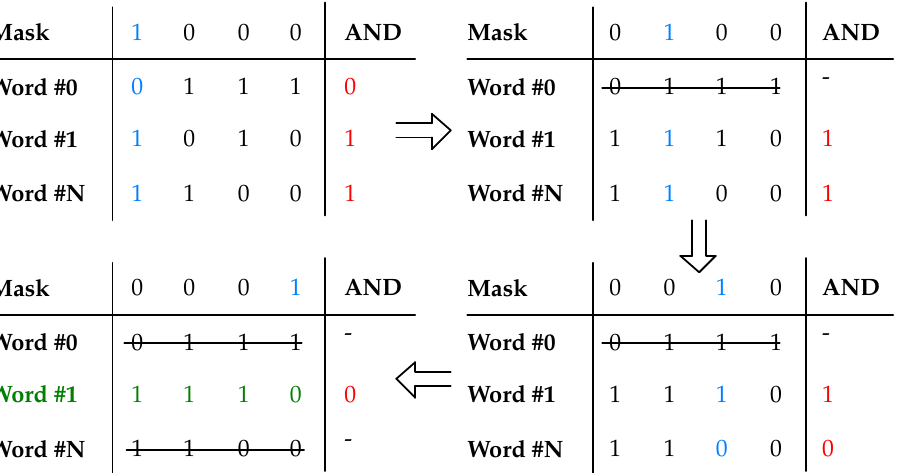
Figure 5. All the words are scanned through a bitwise AND with an external word called “mask vector”. The ones for which a logic ‘0’ is obtained as result, are discarded; the remaining ones at the end are selected as maximum values, and a priority mechanism can be applied to choose among these. In the example, the selected word is highlighted in green.